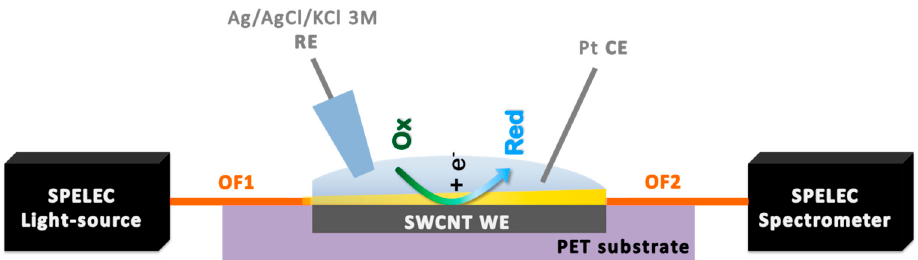
Figure 1. Schematic view of the UV/Vis absorption spectroelectrochemical set-up in parallel configuration. WE: single-walled carbon nanotube (SWCNT) working electrode, CE: Pt counter electrode, RE: Ag/AgCl/KCl 3 M reference electrode, OF1: Naked optical fiber that guides the light beam from the source cell to the solution, OF2: Naked optical fiber that guides the light beam from the solution to the spectrometer, PET: polyethylene terephthalate.